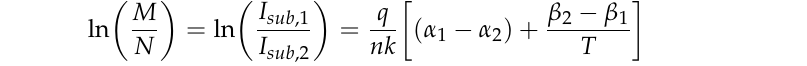
Figure 18. The block diagram showing the operating principle of the subthreshold MOS-based (type II) sensors in [27]. The oscillators 1 and 2 are the reference and the thermal sensing line, respectively.